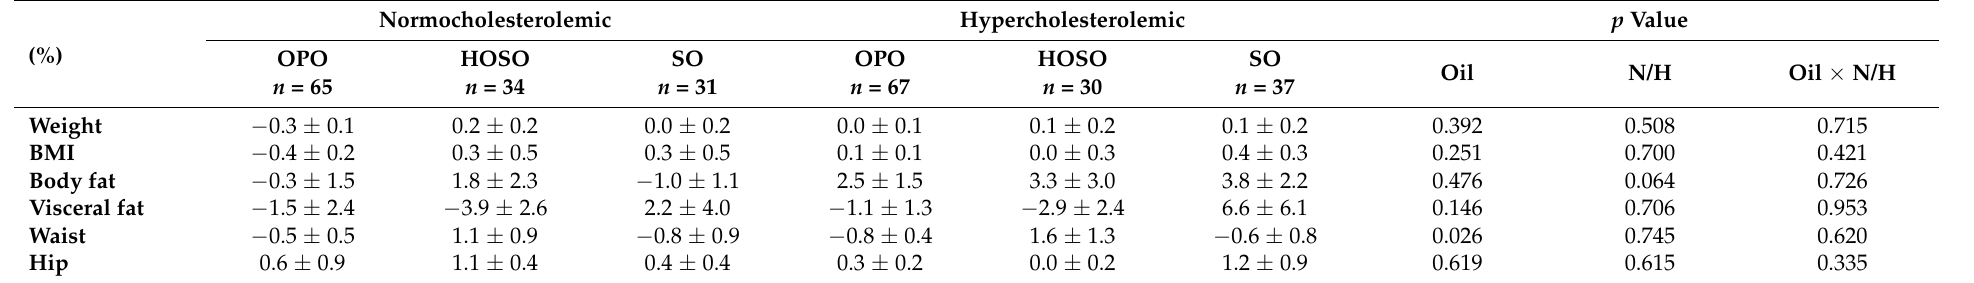
Table 4. Effects of olive pomace oil (OPO), high oleic sunflower oil (HOSO) and sunflower oil (SO) on anthropometric parameters and body